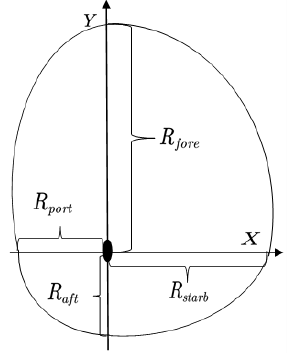
Figure 3. Quaternion ship domain.